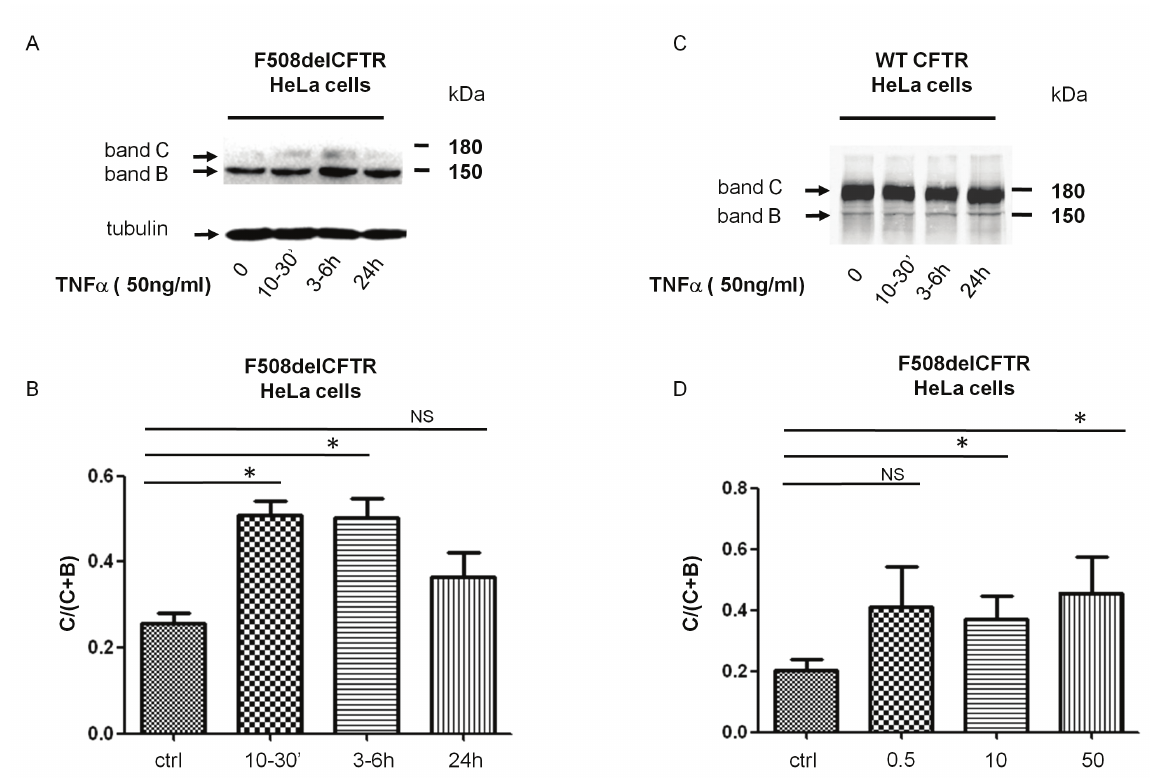
Figure 1. Immunoblot analysis of F508del-CFTR and WT-CFTR expression in HeLa cells. * indicates significant results. A . F508del-CFTR expression after stimulation of cells with 50ng/ml TNF α for 10min, 3–6h and 24h. Band C refers to fully glycosylated F508del-CFTR, band B refers to core glycosylated F508del-CFTR. B . Relative quantification of C/B+C indicating changes in maturation of F508del-CFTR after stimulation of cells with 50ng/ml TNF α for 10min, 3-6 and 24 h, p=0,0046, p=0,0234, p=0,69 (NS) for 10mins, 3–6h and 24 h, respectively. C . WT-CFTR expression after stimulation of cells with 50ng/ml TNF α for 10min, 3–6h and 24h. D . Concentration dependence of expression and the changes in maturation of F508del-CFTR in response to treatment of cells with 0.5, 10 and 50ng/ml TNF α , p=0.12 (NS), p=0.01, p=0.03, respectively.